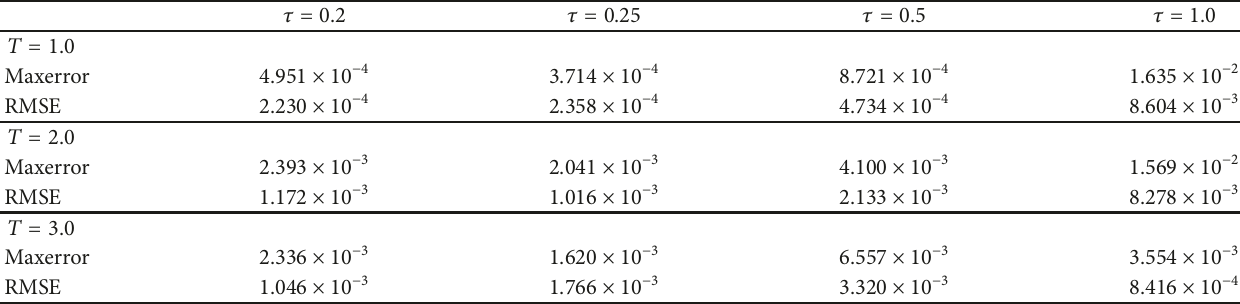
Table 1: Maxerror and RMSE for 𝑇 = 1.0,2.0 and 3.0 with different 𝜏 .